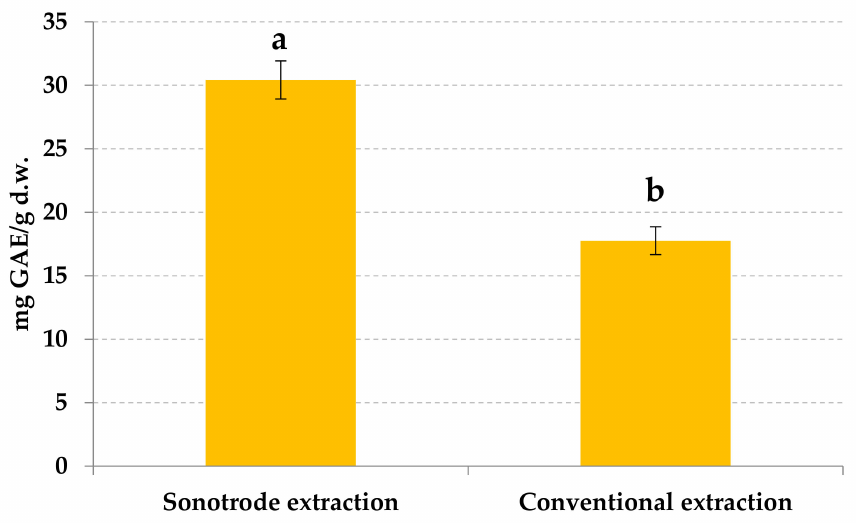
Figure 4. Comparison of phenolic content in orange by-products extracts obtained by sonotrode and conventional extraction. Different letters reported statistical significant